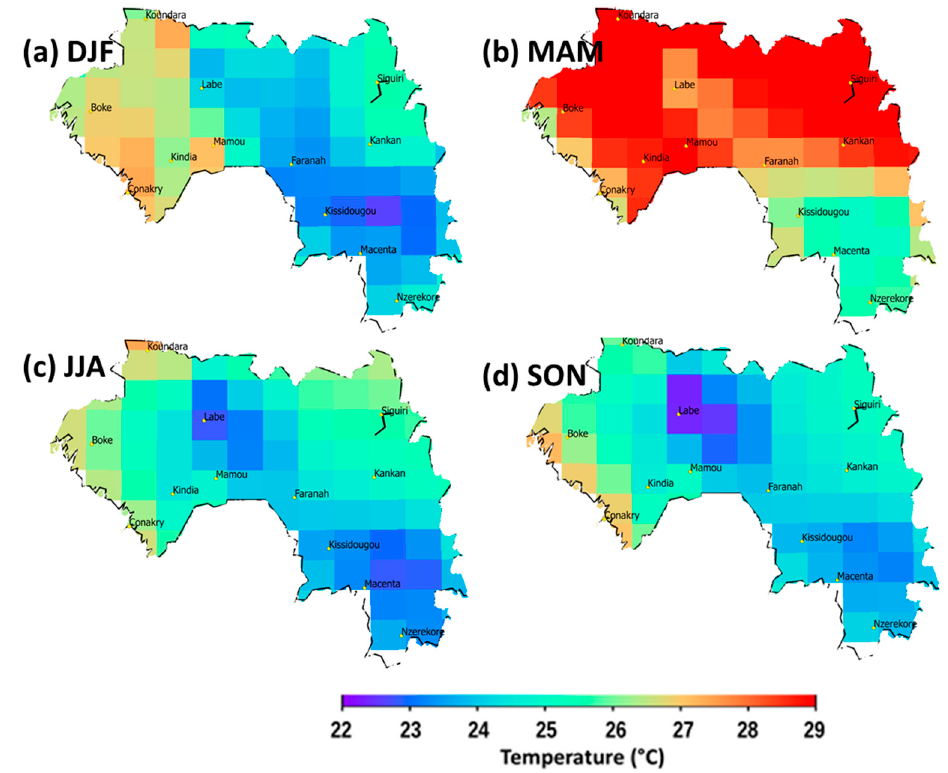
Figure 10. Seasonal variation of MERRA 2 surface air temperature over the 1980–2016 period: ( a ) December–February (DJF), ( b ) March–May (MAM), ( c ) June–August (JJA) and ( d ) September– November (SON).